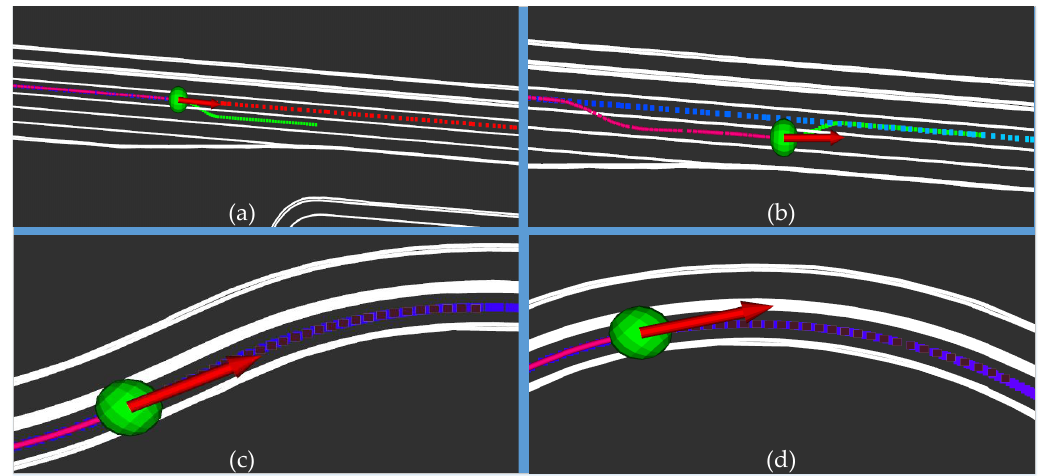
Figure 16. The illustration of local path planning algorithm, ( a , b ) are lane-changing processes, ( c , d ) are path